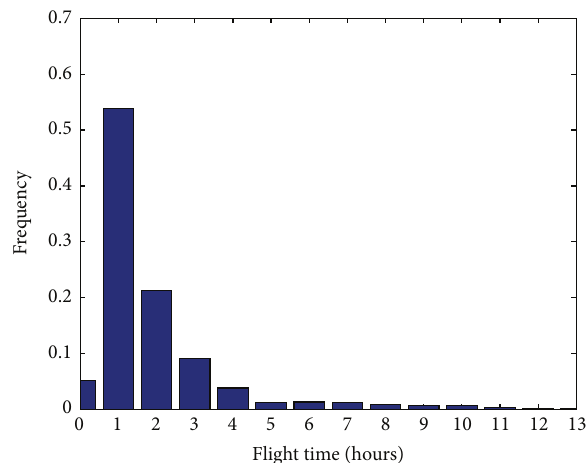
Figure 3: Distribution of flight times for the flights circulating in European traffic network in 2015.